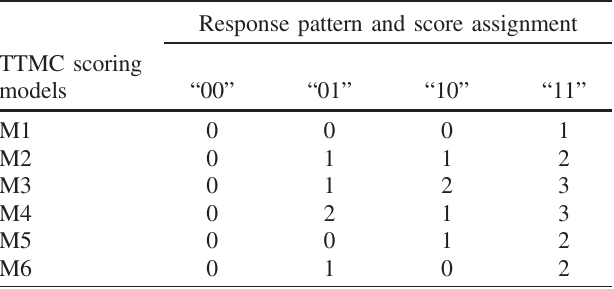
TABLE I. Summary of six scoring methods of two-tier item pairs. Response pattern and score assignment TTMC scoring